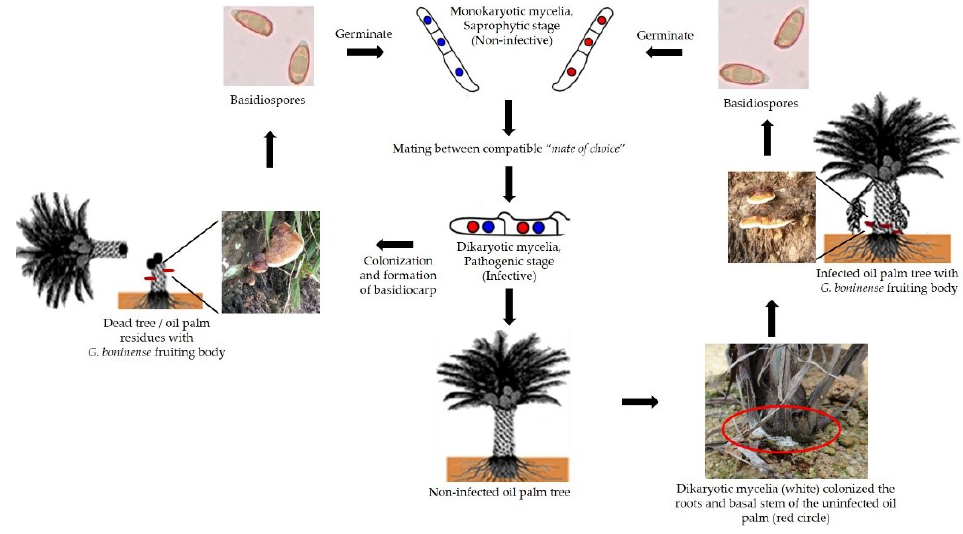
Figure 2. The life cycle of G. boninense . The G. boninense fruiting bodies produce millions of basidiospores which can be spread by numerous vectors, such as wind and animals. The basidiospore germinates to form mycelia (monokaryotic form), which is non-pathogenic to the oil palm tree [33]. The mating between compatible mates of choice (monokaryon/dikaryon) will form the pathogenic dikaryotic mycelia. The dikaryotic mycelia then begins to colonize the root and basal stem of the oil palm tree. Dikaryotic mycelia will undergo hyphae morphogenesis to form a needle-like structure to facilitate the penetration into the host cells. G. boninense infection of the oil palm tree will manifest as the formation of basidiocarps on the basal stem of the infected tree. However, there are cases where the palms dies and collapses in the field without the formation of a G. boninense fruiting body.